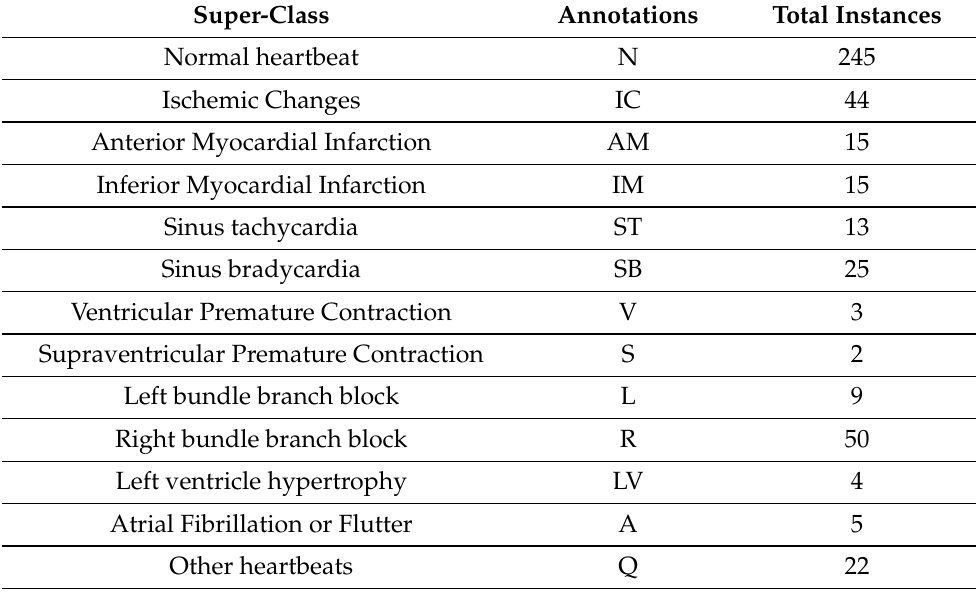
Table 5. UCI Arrhythmia Dataset (D1) Class-Instance Distribution.